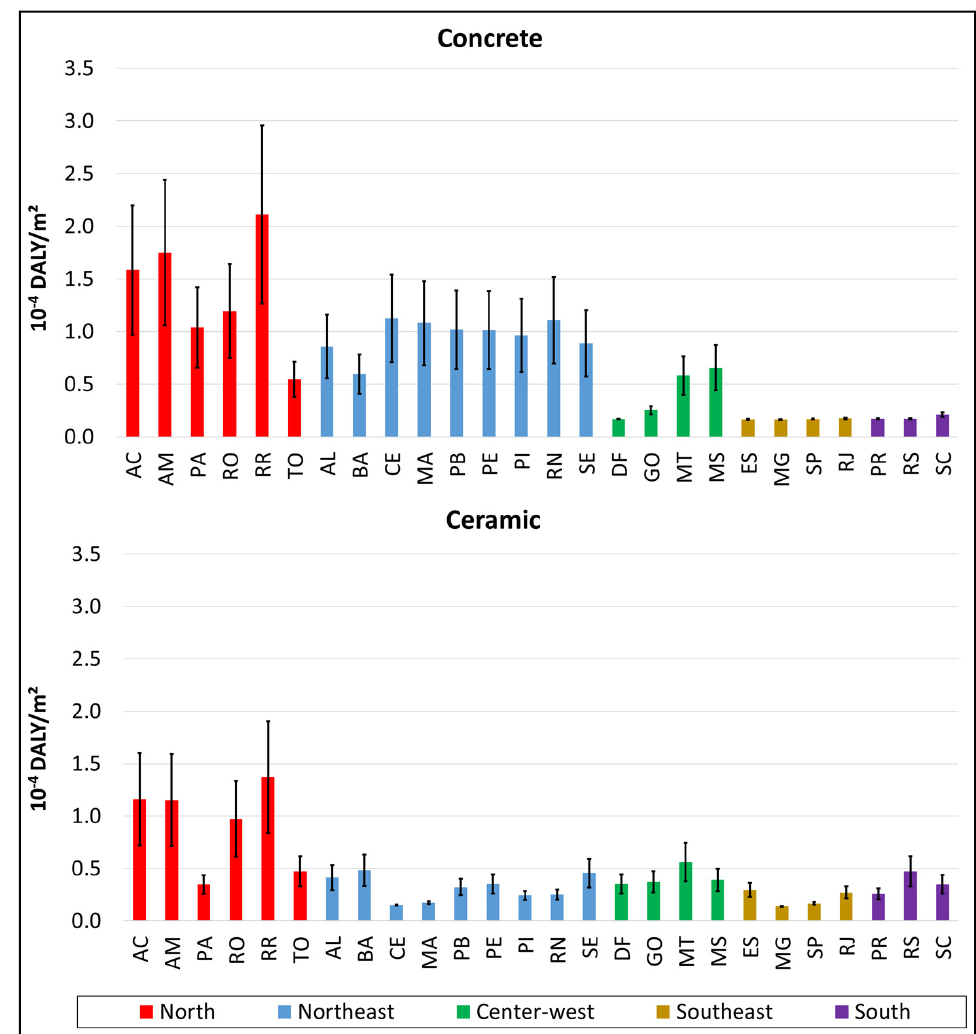
Figure 4. Total Human Health impact. The error bars represent the standard deviation due to transportation scenarios.